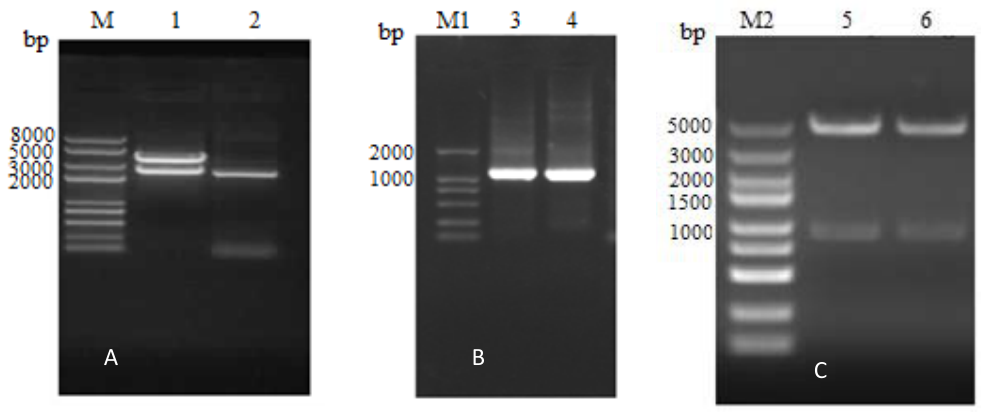
Figure 2. Identification of recombinant plasmids. (A) Lane M represents the DNA